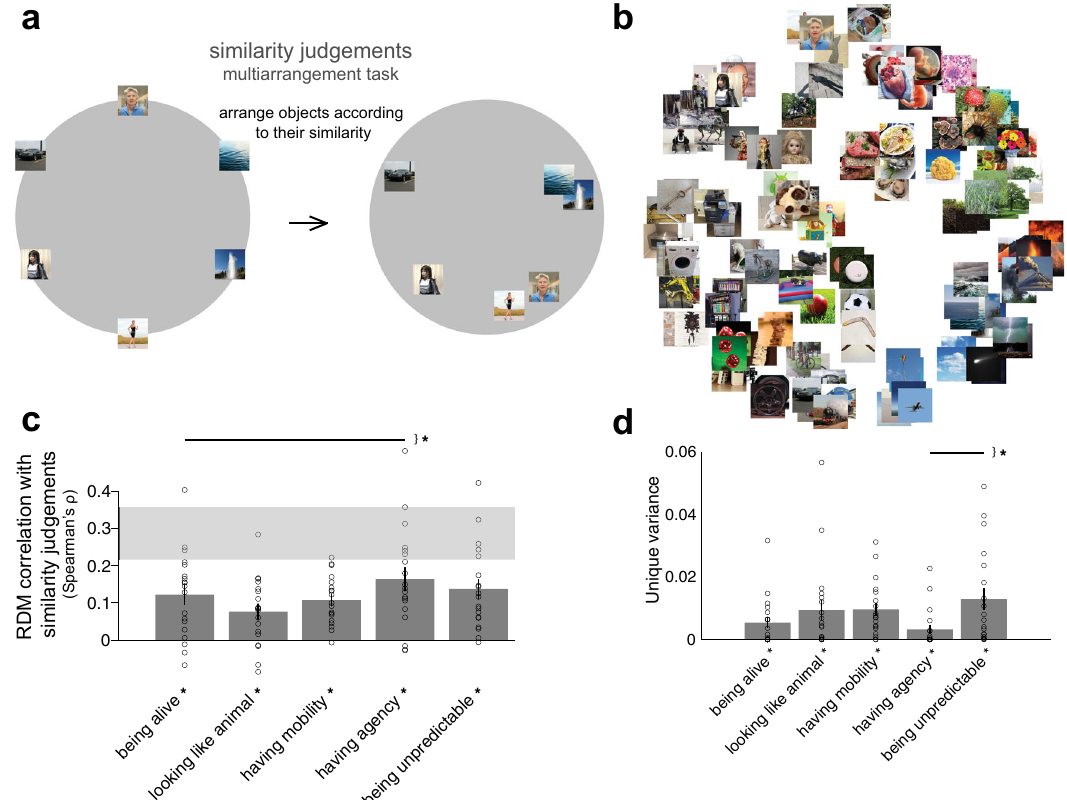
Fig. 5 Dimensions of animacy and similarity judgements. a Similarity judgements multiarrangement task. During this task, object images were shown on a computer screen in a circular arena, and participants were asked to arrange the objects according to their similarity, such that similar objects were placed close together and dissimilar objects were placed further apart. Participants performed multiple arrangements of subsets of the images, enabling us to estimate the underlying perceptual similarity space (see Methods for details). b Multidimensional scaling plot of similarity judgements (mean across 19 participants, with metric stress criterion). c Animacy dimension RDM comparisons with similarity judgements RDMs. Bars show the correlation between the similarity judgements RDMs and each animacy dimension RDM. A signi fi cant correlation is indicated by an asterisk (one-sided Wilcoxon signed-rank test, p < 0.05 corrected). Error bars show the standard error of the mean based on single-participant correlations, i.e., correlations between the single- participant similarity judgements RDMs and animacy dimension RDM. Circles show single-participant correlations. The grey bar represents the noise ceiling, which indicates the expected performance of the true model given the noise in the data. Horizontal lines show signi fi cant pairwise differences between model performance ( p < 0.05, FDR corrected across all comparisons), an asterisk to the right of horizontal lines indicates their signi fi cance. d Unique variance of each animacy dimension in explaining similarity judgements. For each animacy dimension m, the unique variance was computed by subtracting the total variance explained by the reduced GLM (excluding the dimension of interest) from the total variance explained by the full GLM. Speci fi cally, for dimension m, we fi t GLM on X = “ all dimensions but m ” and Y = data, then we subtract the resulting R2 from the total R2 ( fi t GLM on X = “ all dimensions ” and Y = data). We used non-negative least squares to fi nd optimal weights. A signi fi cant unique variance is indicated by an asterisk (one-sided Wilcoxon signed-rank test, p < 0.05 corrected). The error bars show the standard error of the mean based on single-participant unique variance. Circles show single-participant unique variance. Horizontal lines show signi fi cant pairwise differences between model performance ( p < 0.05, FDR corrected across all comparisons), an asterisk to the right of horizontal lines indicates their signi fi